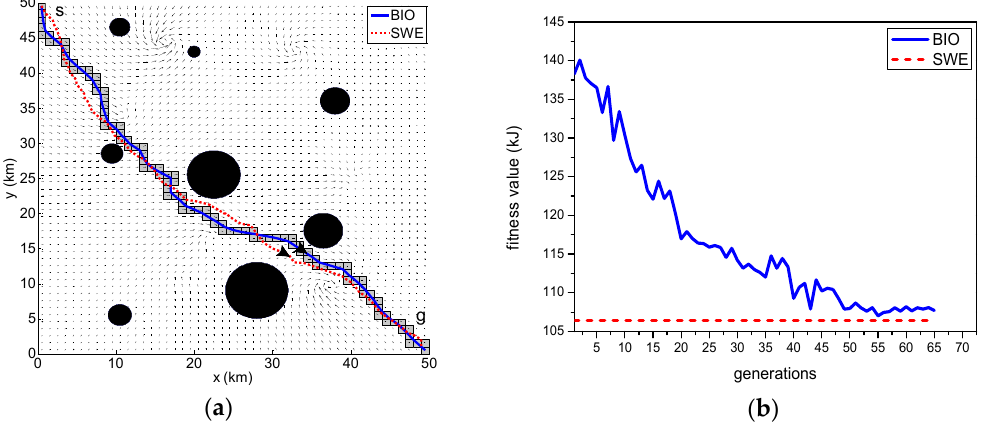
Figure 6. Comparison of results produced by the BIO and SWE schemes in the environment with fixed uncertainty obstacles: ( a ) the optimal path generated by BIO and SWE schemes. ( b ) convergence curve of the upper level of BIO scheme.